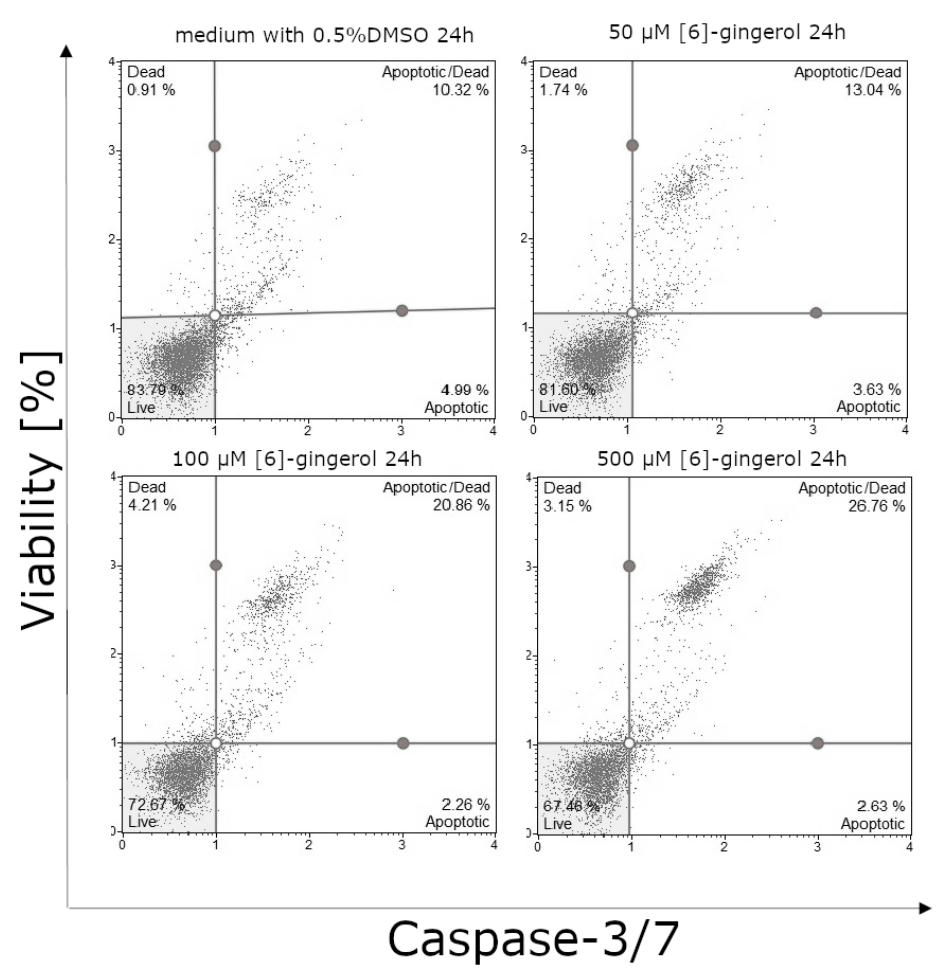
Figure 7. [6]-gingerol induce apoptosis in the U-118MG cells. Cells were treated with DMSO or various concentrations of [6]-gingerol for 24 h. Adherent cells were collected and stained with a Muse TM Caspase-3 / 7 Reagent and 7-AAD and events for live cells were counted with the Muse Cell